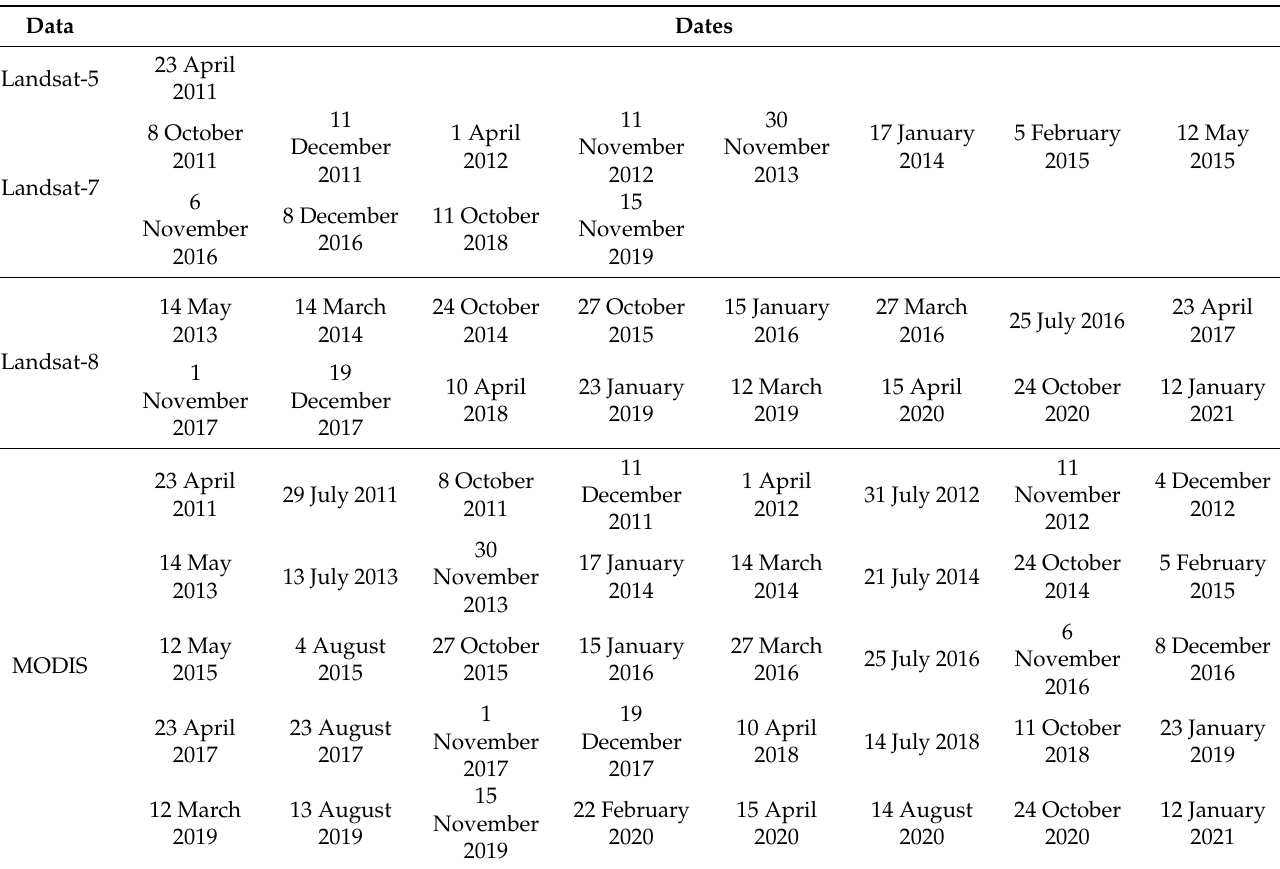
Table 1. Data used in the study (The dates of the fusion data are marked in